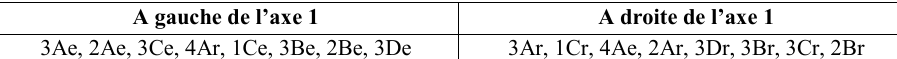
Tableau 5. Positionnements des modalités sur l’axe